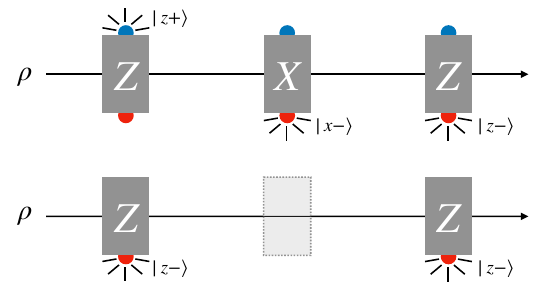
FIG. 12. A simple quantum process that violates the assump- tions of the KET. Successive measurements of the spin of a particle do not allow one to predict the statistics if the spin- 1 2 intermediate measurement is not conducted. Here, measuring in the x basis is invasive, and thus summing over the respective outcomes is not the same as not having done the measurement at all.